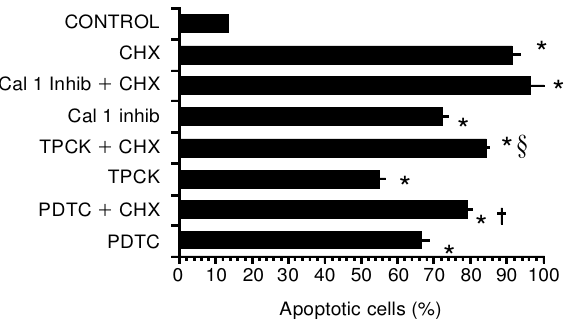
FIG. 5. Effects of cycloheximide (CHX) on apoptosis in- duced by NF- k B inhibitors. RAW 264.7 cells were incubated for 18 h with CHX (10 m g / ml), calpain I inhibitor (10 m M), TPCK (25 m M) or PDTC (100 m M). The percentage of cells undergoing apoptosis as assessed by acridine orange staining is shown on the abscissa. Error bars represent SEM. , signi® cant increase in apoptosis (P , 0 · 001) in treated cells compared to control cells; § , signi® cant in- crease (P , 0 · 001) in apoptosis in cells treated with TPCK and CHX compared to cells treated with TPCK alone; + signi® cant increase (P , 0 · 01) in apoptosis in cells treated with both PDTC and CHX compared to cells treated with PDTC alone. Each experiment was repeated at least three